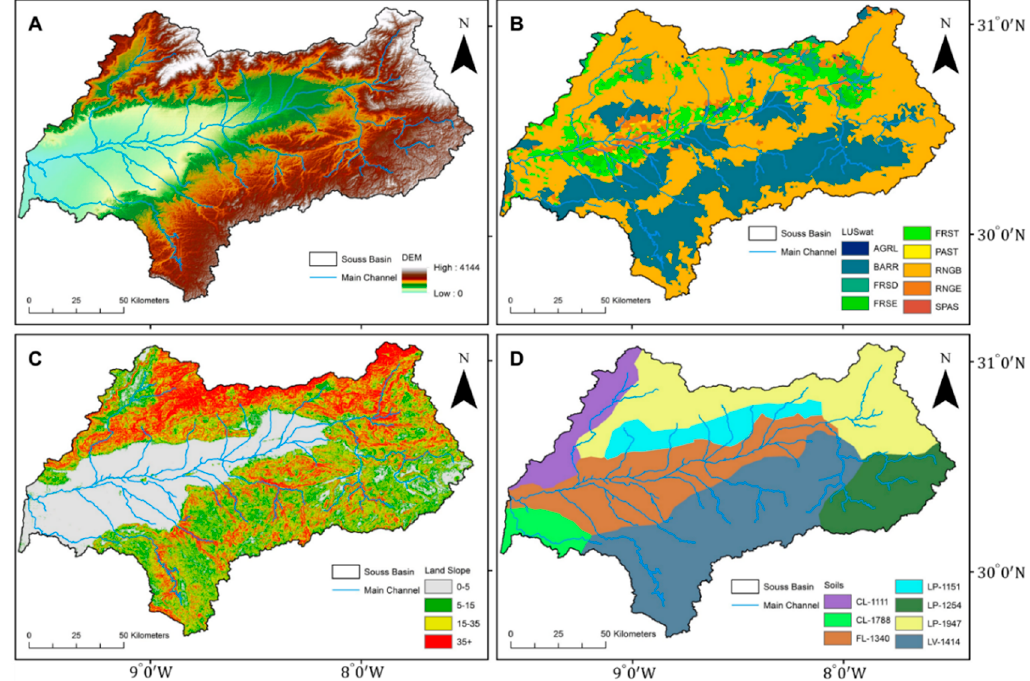
Figure 7. Souss Model input: ( A ) Digital Elevation Model; ( B ) landuse; ( C ) percent slope; and ( D ) soils.